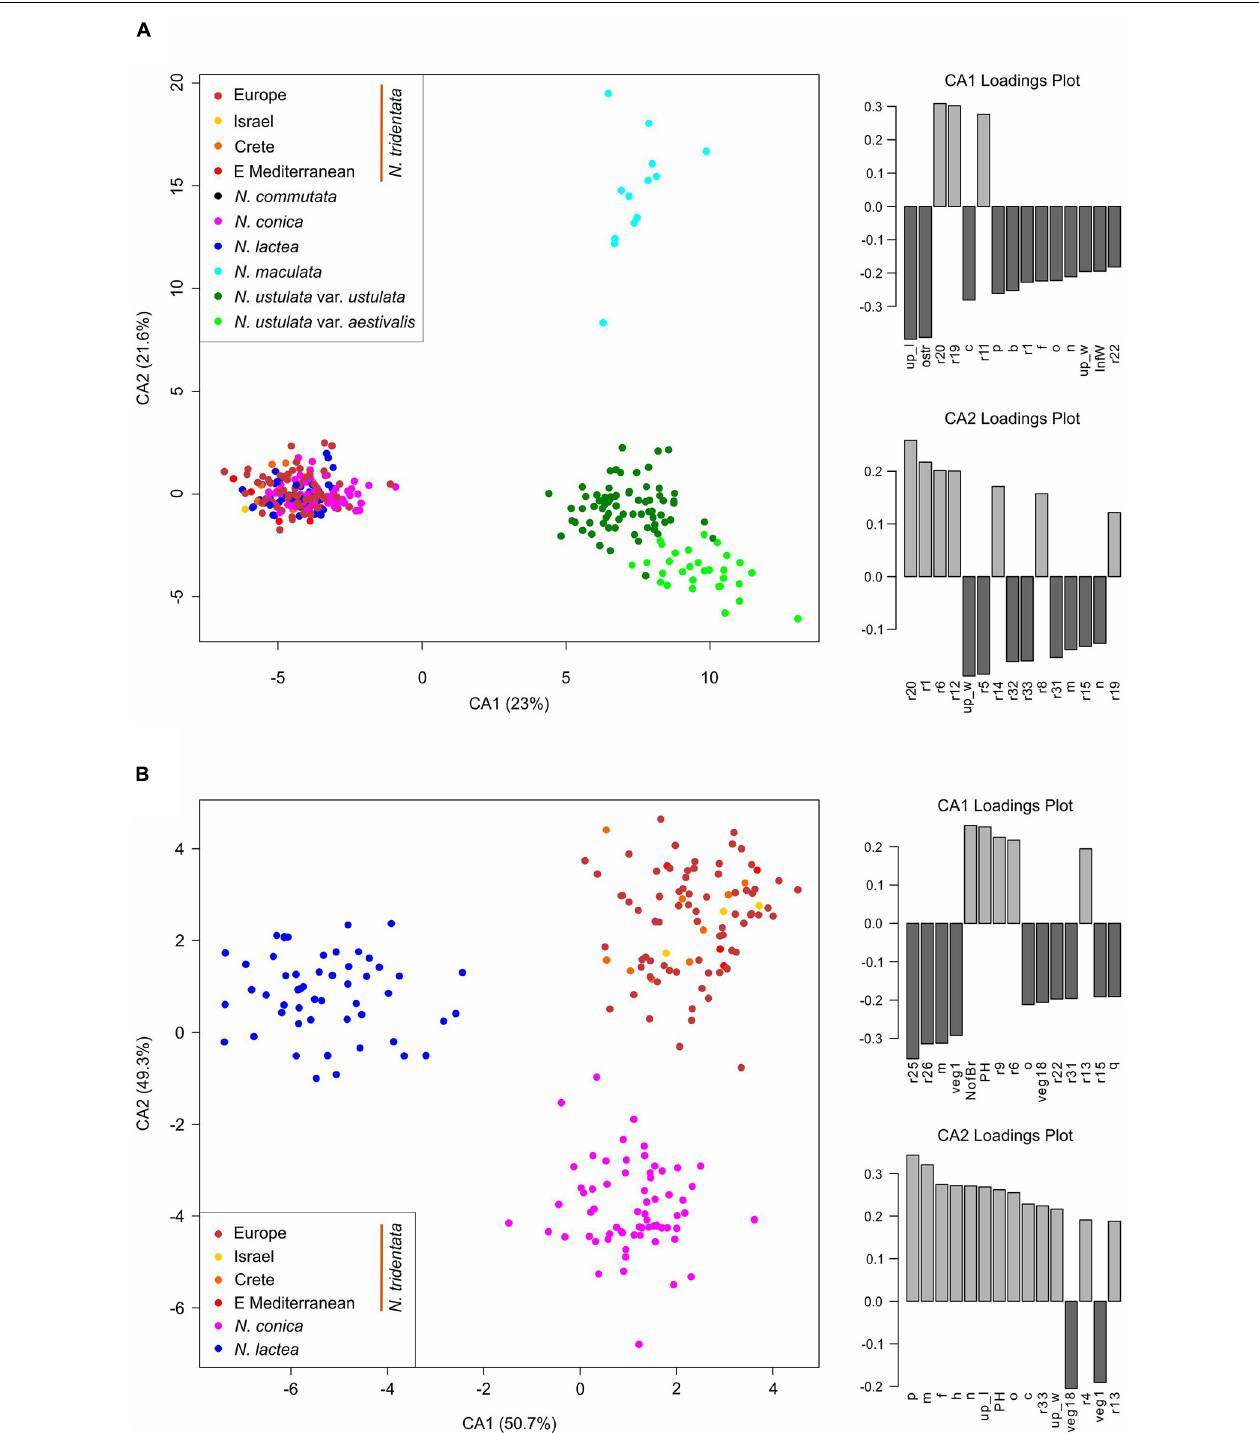
FIGURE 8 | Multivariate morphometrics: canonical discriminant analysis (CDA) of (A) 322 individuals with the full record of data, with one accession of N. commutata excluded, and (B) 208 individuals with the full record of data, belonging to N. conica , N. lactea, and N. tridentata . Although the separation of populations within N. tridentata is retained (indicated by the different colors), the whole complex is treated as a single group (in both analyses). The two right-hand panes belonging to each ordination show the ordered association of characters with the first and second axis of the CA, respectively.